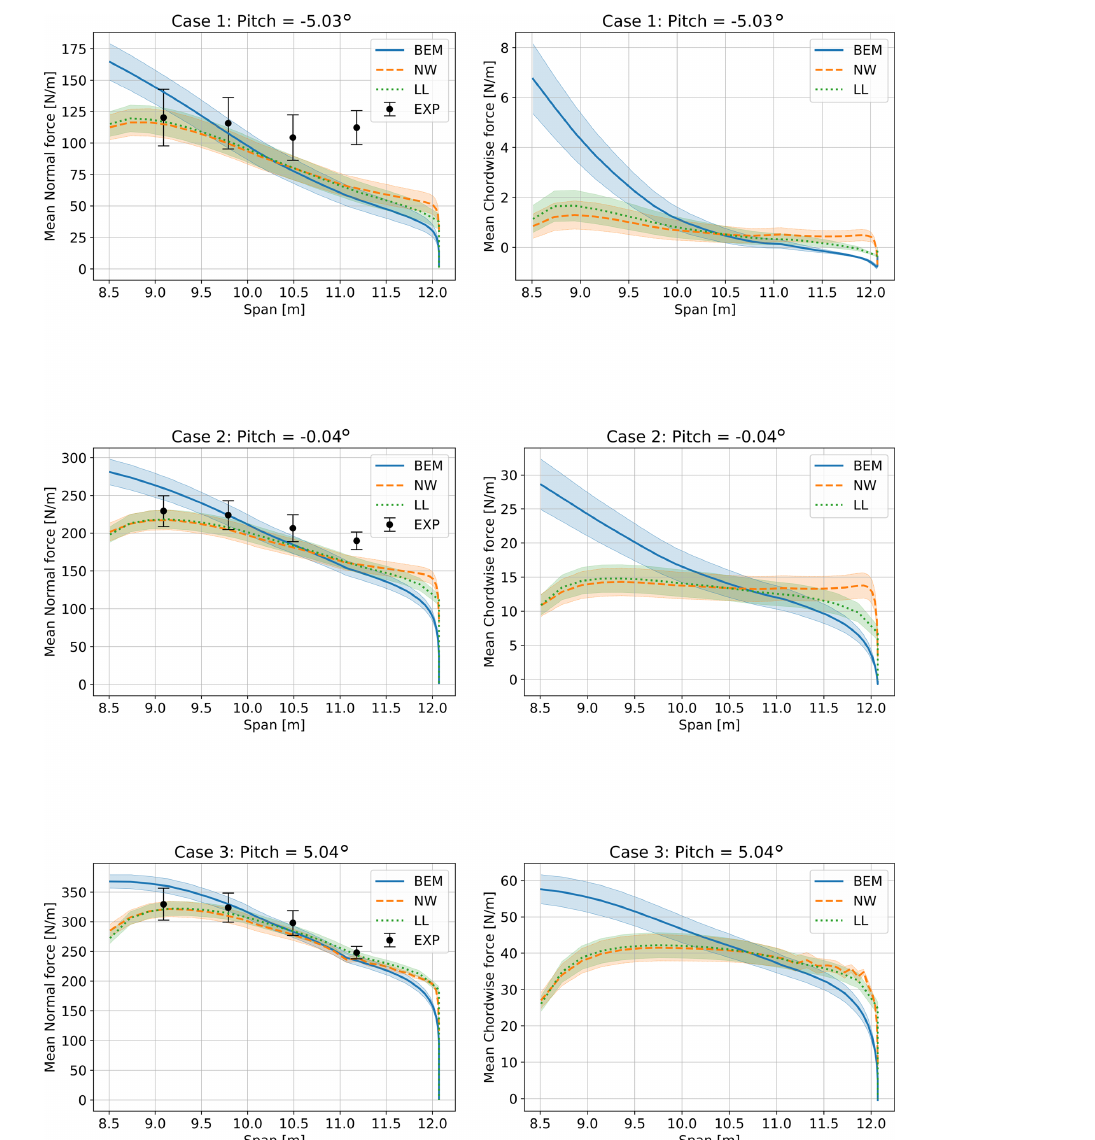
Figure 17. Comparison of normal and chordwise force from turbulent simulations and the experiment. Results shown are averaged from four turbulent seeds per pitch angle, using the mean operating conditions as shown in Table 3 up to a pitch angle of 5 ◦ . The shaded areas show the standard deviation between the mean values of the four simulations per pitch angle, to indicate the variability due to turbulent seed.